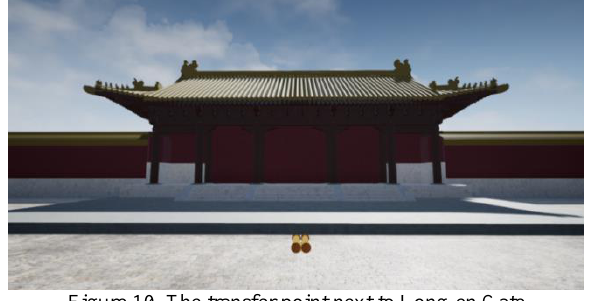
Figure 10. The transfer point next to Long-en Gate